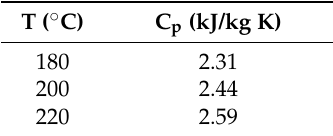
Table 1. Specific heat capacity ( C p ) values for three temperatures of mesophase interval of 10-BPhCOOH.